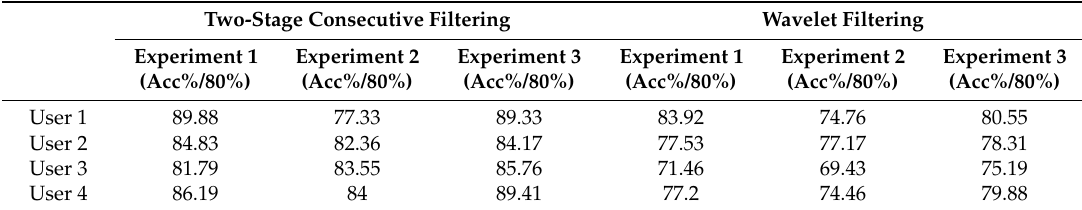
Table 8. Classification performance obtained from IMU sensors: filtering comparison.